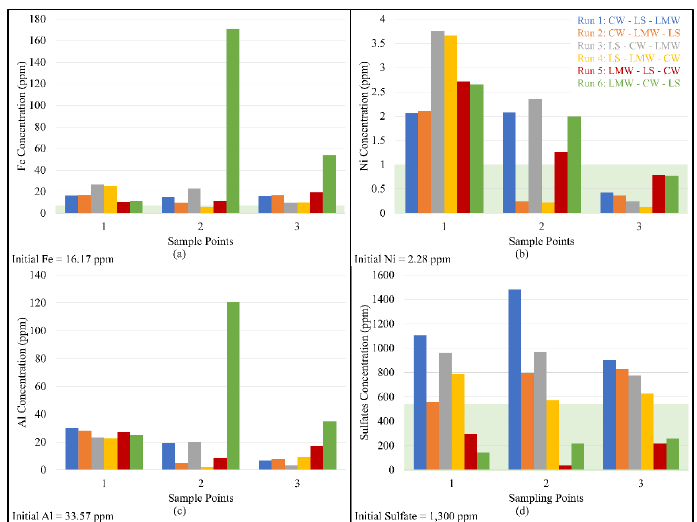
Figure 5. Change in ( a ) Fe, ( b ) Ni, ( c ) Al, and ( d ) sulfates concentration with Type C effluent standards highlighted in green [44,45].